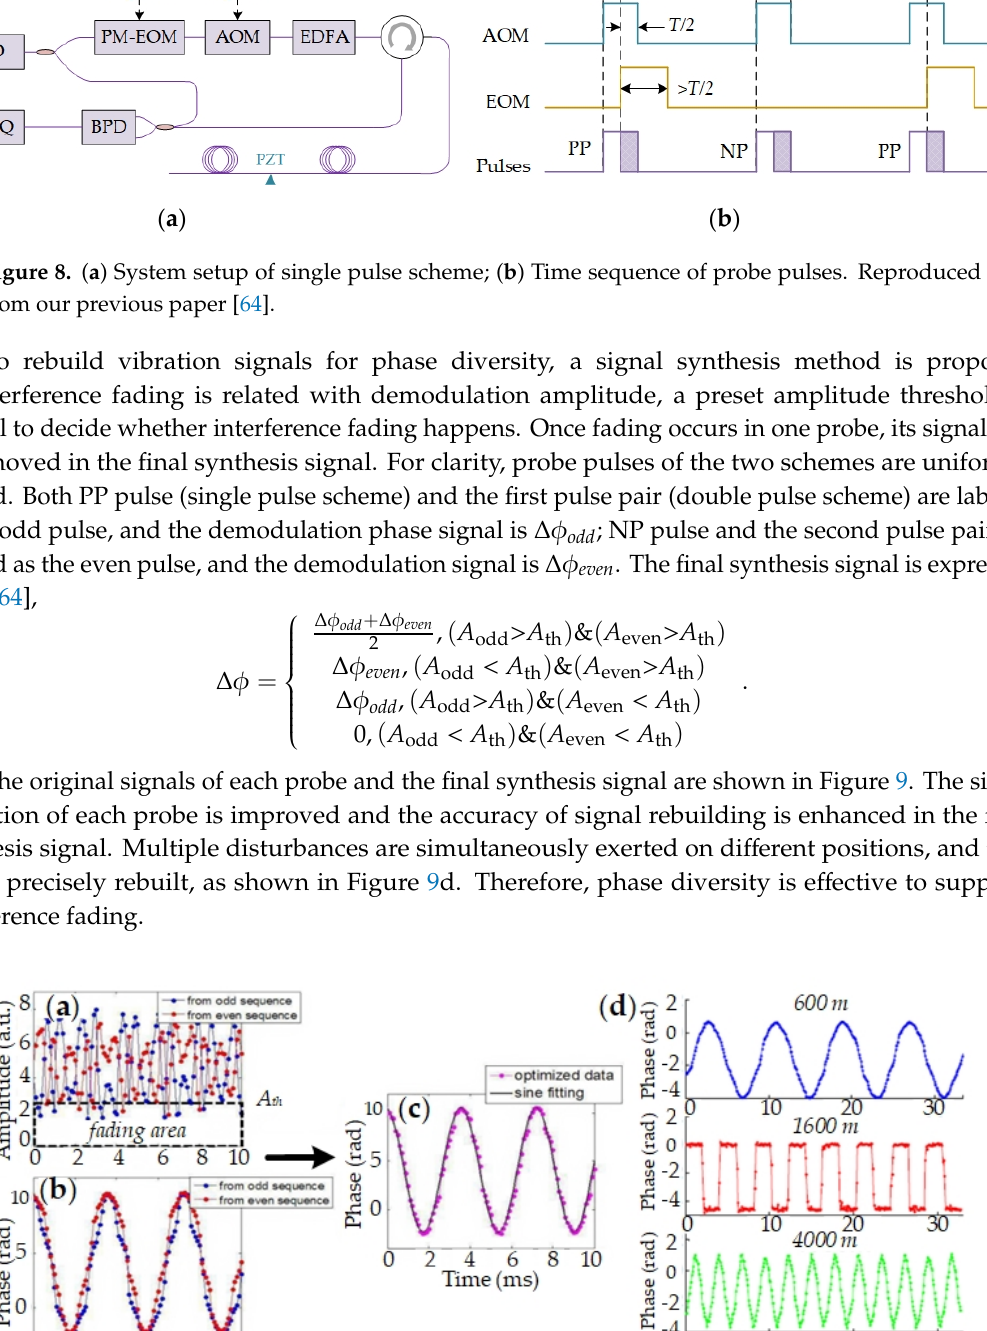
Figure 7. Experimental diagrams. ( a ) System setup of double pulse scheme; ( b ) Pulse pair; ( c ) Beat signal of different pulse pairs. Reproduced from our previous paper [63] and [15].